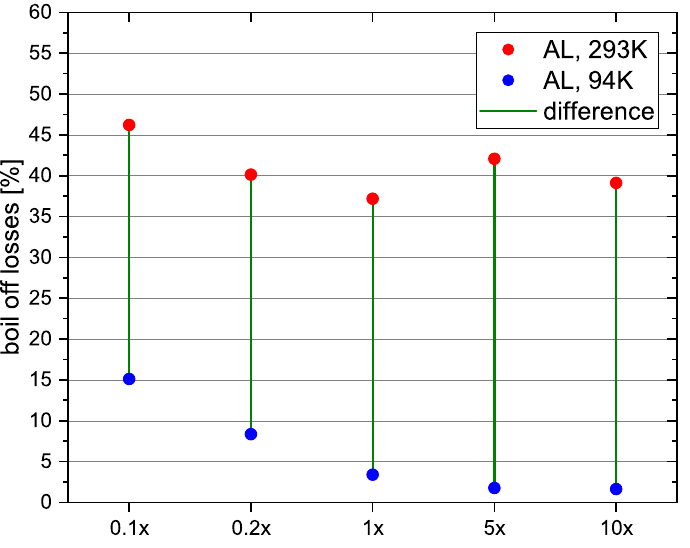
Figure 11. Relvative boil-off losses for different mass flows.